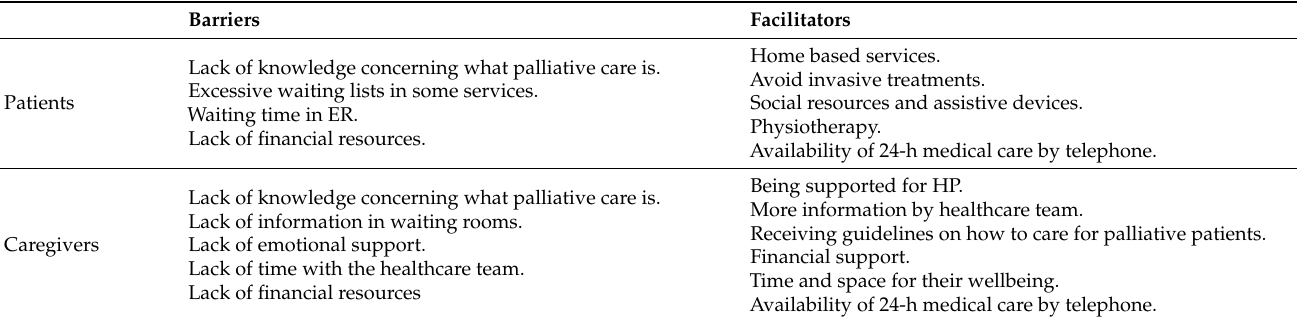
Table 2. Perceived barriers and facilitators for Palliative care